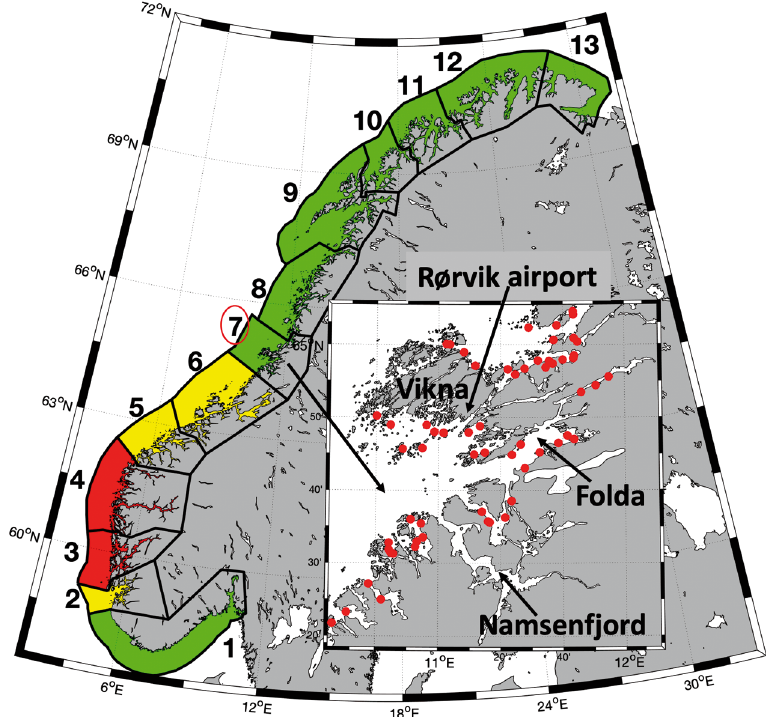
Fig. 1. Aquaculture traffic-light system in Norway in 2017. The 13 aquacul- ture production zones along the Norwegian coast were classified according to lice-induced mortality of wild migrating salmon post-smolts. Green indicates <10% mortality and allows a 6% growth in aquaculture production; yellow indicates 10−30% mortality and therefore zero growth. Red denotes >30% mortality and requires a 6% decrease in salmonid aquaculture production volume in those zones. Inset shows the study area in Production Zone 7, where the red dots mark the positions of all fish farms used in this